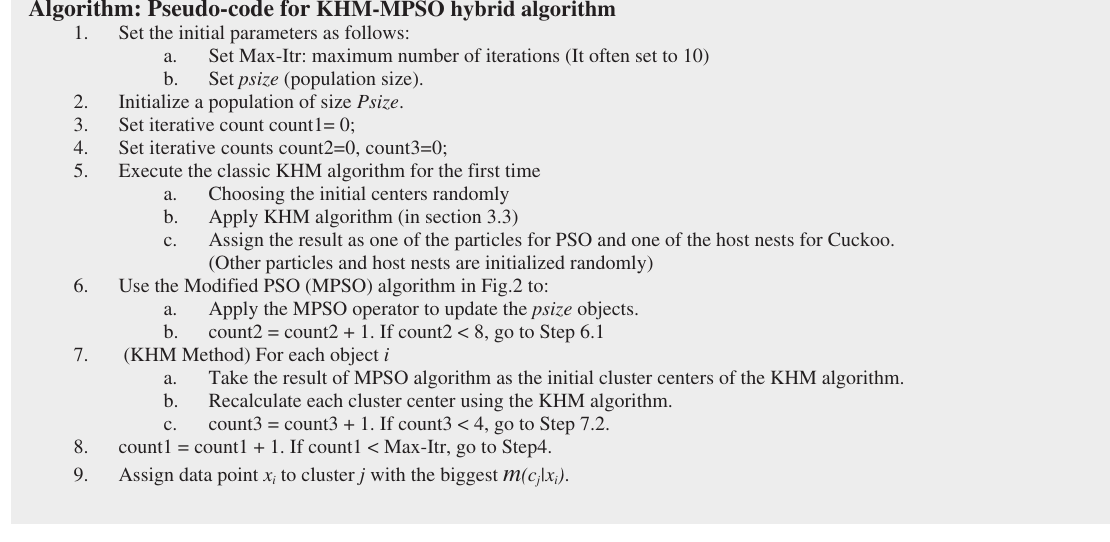
Figure 4: Pseudo-code of the Proposed KHM–MPSO